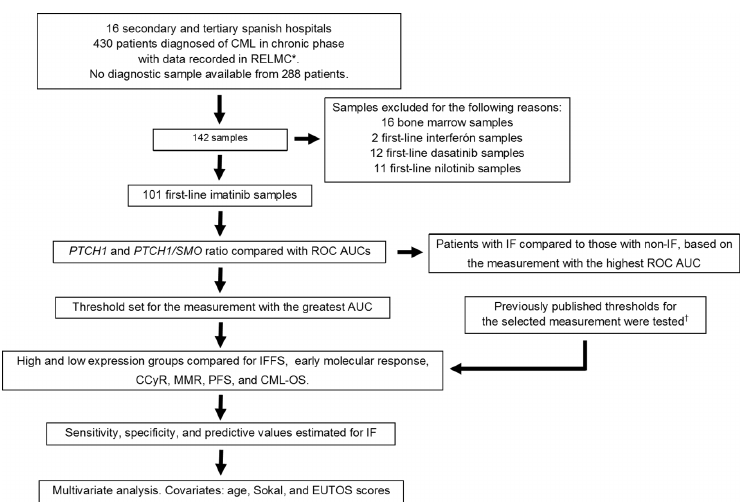
Fig 1. Flow diagram of sample selection and study design. RELMC, SpanishCML registry; IF, imatinib failure; IFFS, imatinibfailure-freesurvival; CML-OS, overall survival related to CML. * Clinicaldata for 40 patients from two hospitalswere collected ad hoc . †Groups established with previous thresholds were only comparedin a univariateanalysis.